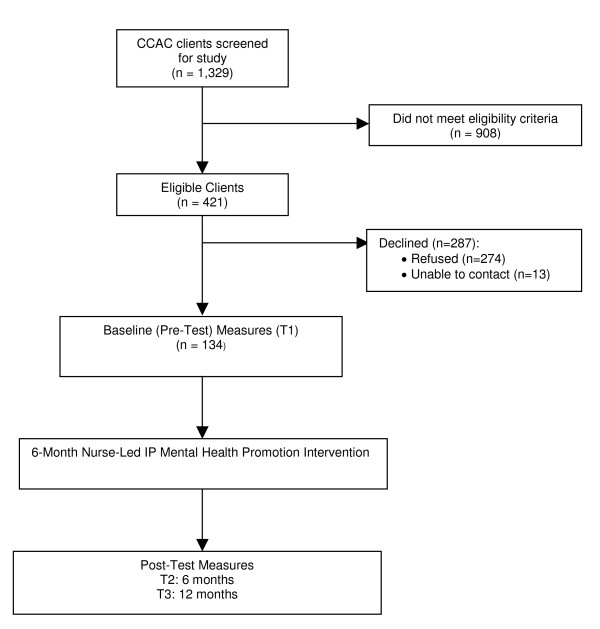
Study Flow Diagram.